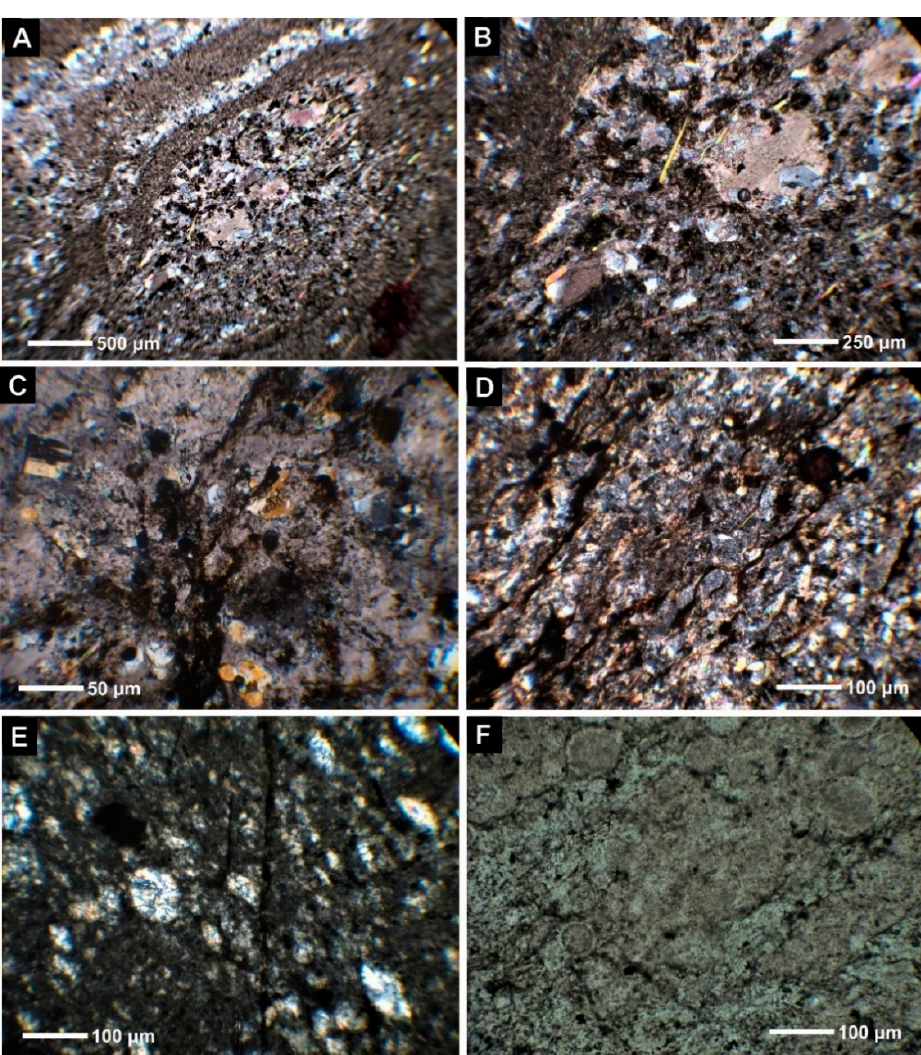
Figure 10. Meliata Unit rock textures: ( A , B ) calciclastic flysch metasediments at Jaklovce (s. JAK-202A); recrystallised coarse-grained layers contain newly formed Cal, Dol, Ab, Kfs and Ms clasts; ( C ) recrystallised coarse-grained layers of carbonates with Ab in calciclastic flysch metasediments at Dobšiná (s. DO-F1); ( D ) cherty siliciclastic flysch metasediments (s. MEL-2/19) at Meliata village; ( E ) chalcedony to mosaic Qtz pseudomorphs after flattened and stretched radiolarians in a dark red Triassic (meta)radiolarite olistolith in the flysch (s. MEL-17B/19); and ( F ) greenish newly formed Chl-bearing metaradiolarite layers in flysch metasediments at Meliata with less deformed radiolarians (s. MEL-14/19). Picture F at II N; A – E at X N.